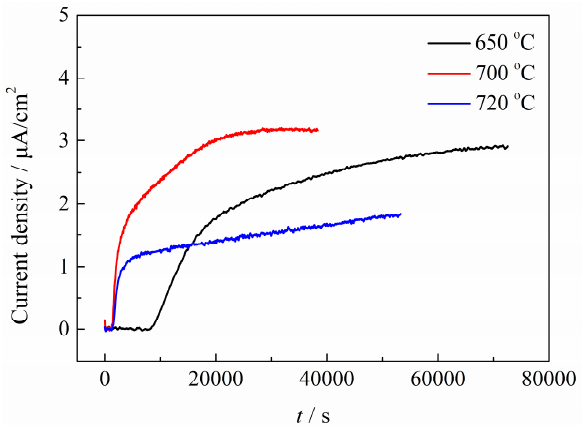
Figure 12. H permeation curves for Q&T–treated samples at differing T t . Table 3. H permeation test results for Q&T–treated samples at differing T t . T t /°C